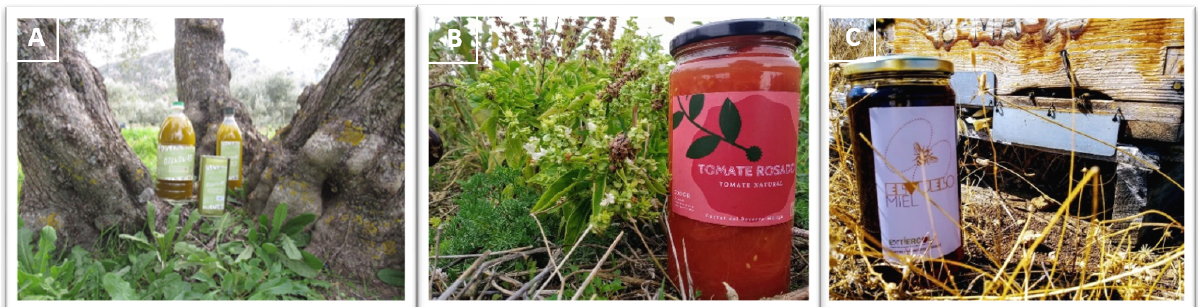
Figure 6. Products packaged in Extiercol project: ( A ) Olive oil, ( B ) Tomato jars, ( C ) Honey.